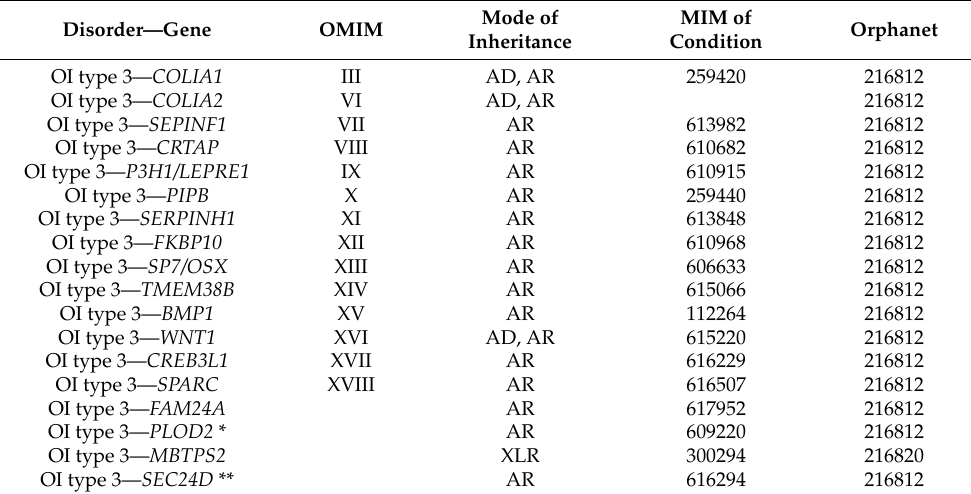
Table 8. Potentially Progressively Deforming OI with usually sclerae (OI Type 3).